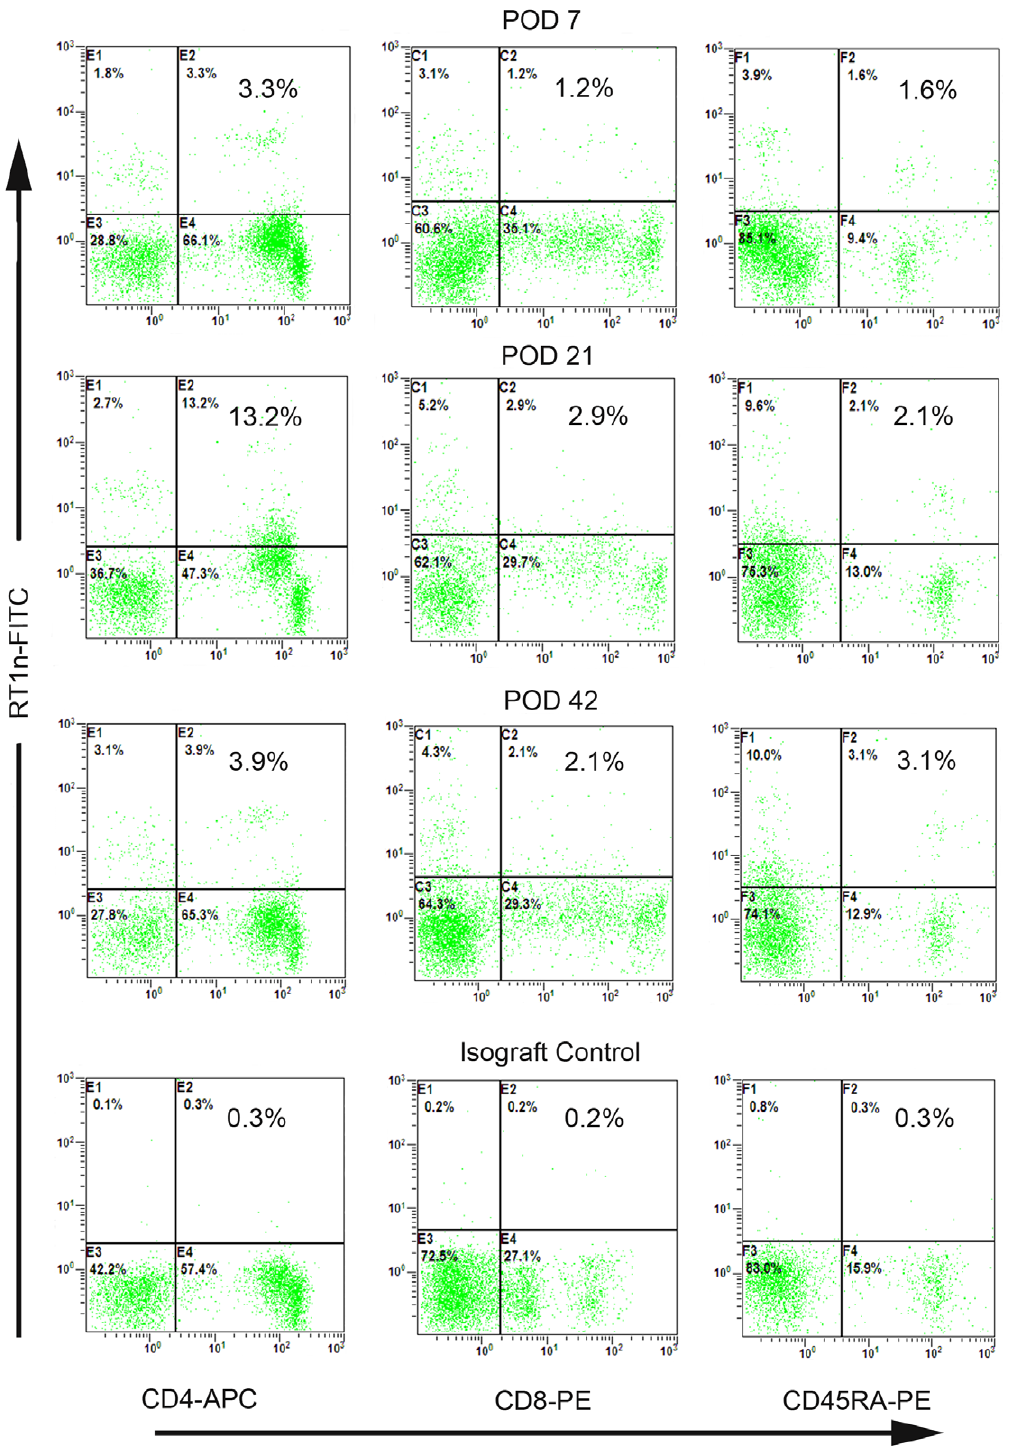
Figure 4. Dynamic changes in peripheral and myeloid chimerism. (a) Time kinetics of chimerism in groups 5 and 6. At POD 7, they showed almost the same chimerism level ( P . 0.05). At POD 21, the level of chimerism in group 6 was mildly decreased, but it increased sharply in group 5 ( P , 0.05). At POD 42, chimerism in group 5 returned to a total level 8.7% 6 0.6% but it decreased to background level in group 6 ( P , 0.05). In addition, donor-origin CD45RA + B cells in group 5 prevailed beginning at POD 21 and maintained thereafter. (b) Myeloid chimerism was detectable at 6.3 6 0.5% at POD 100 in group 5 and it never appeared in group 6 when allografts were rejected (n=6, P , 0.05).